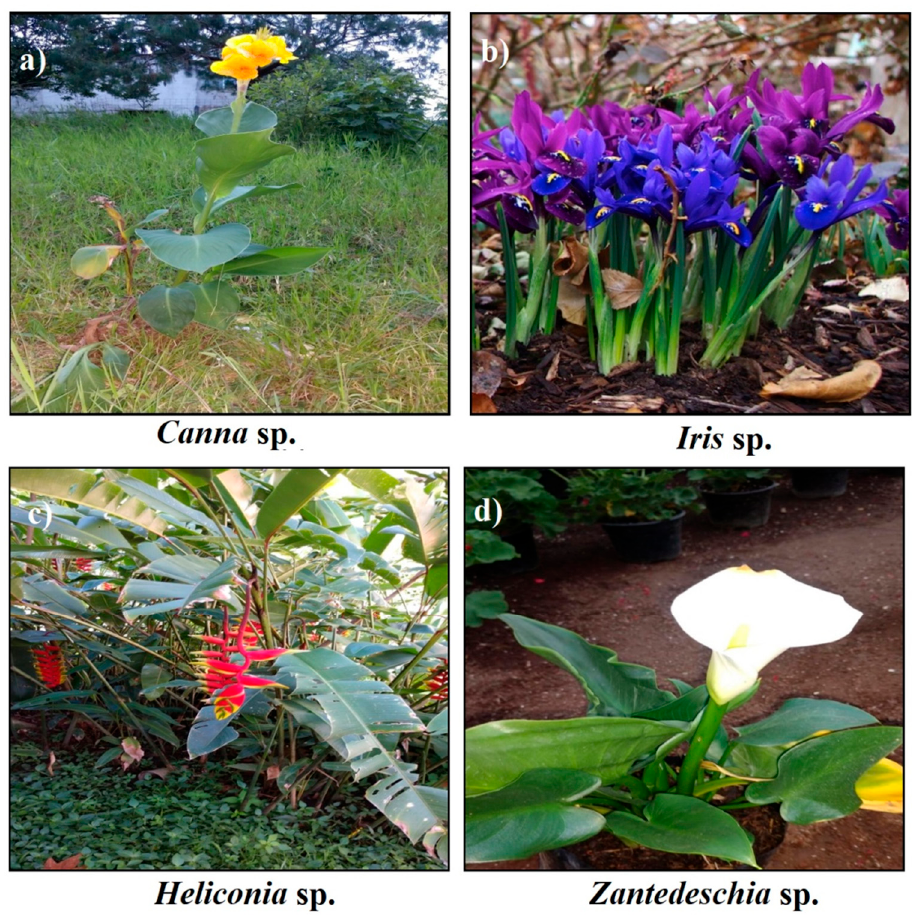
Figure 1. Popular Ornamental flowering plants used in CWs (constructed wetlands). ( a ) Canna sp.; ( b ) Iris sp., ( c ) Heliconia sp. and ( d ) Zantedeschia sp.